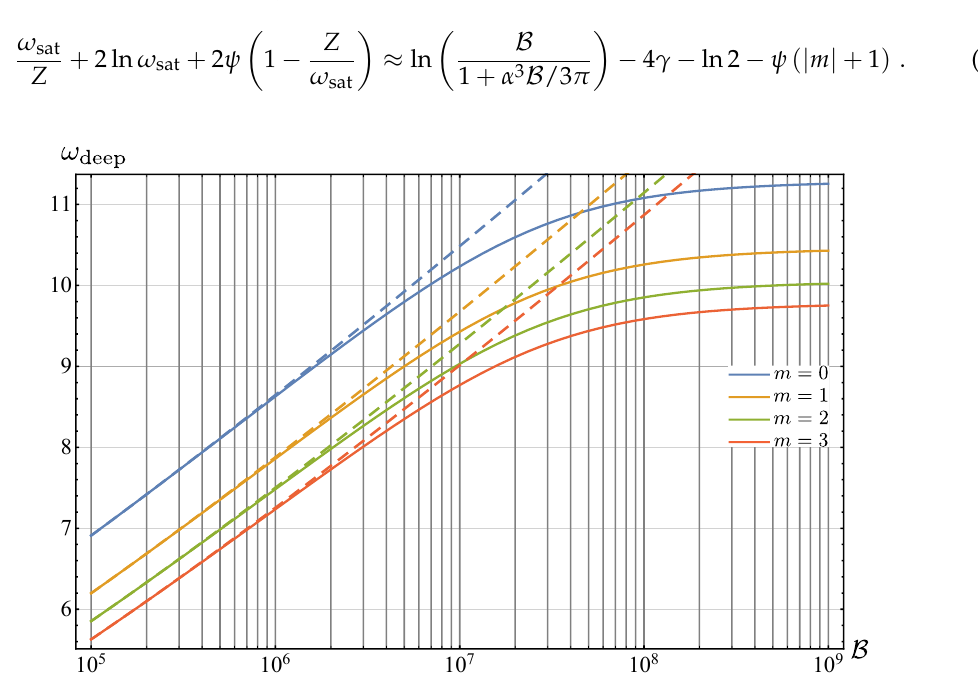
Figure 4. (color online) Deepest energy levels (in Rydberg units) of even states of the Hydrogen atom in the local approximation (solid lines) and neglecting VP (dashed